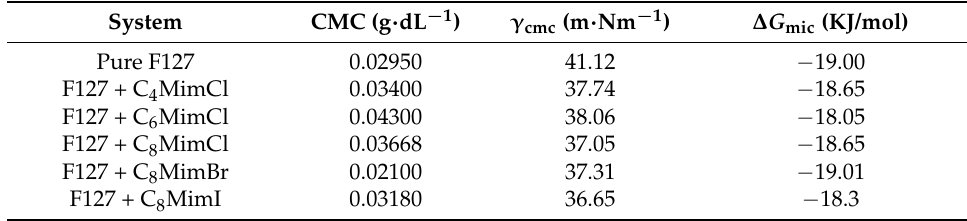
Table 2. CMC values parameters obtained from surface tension